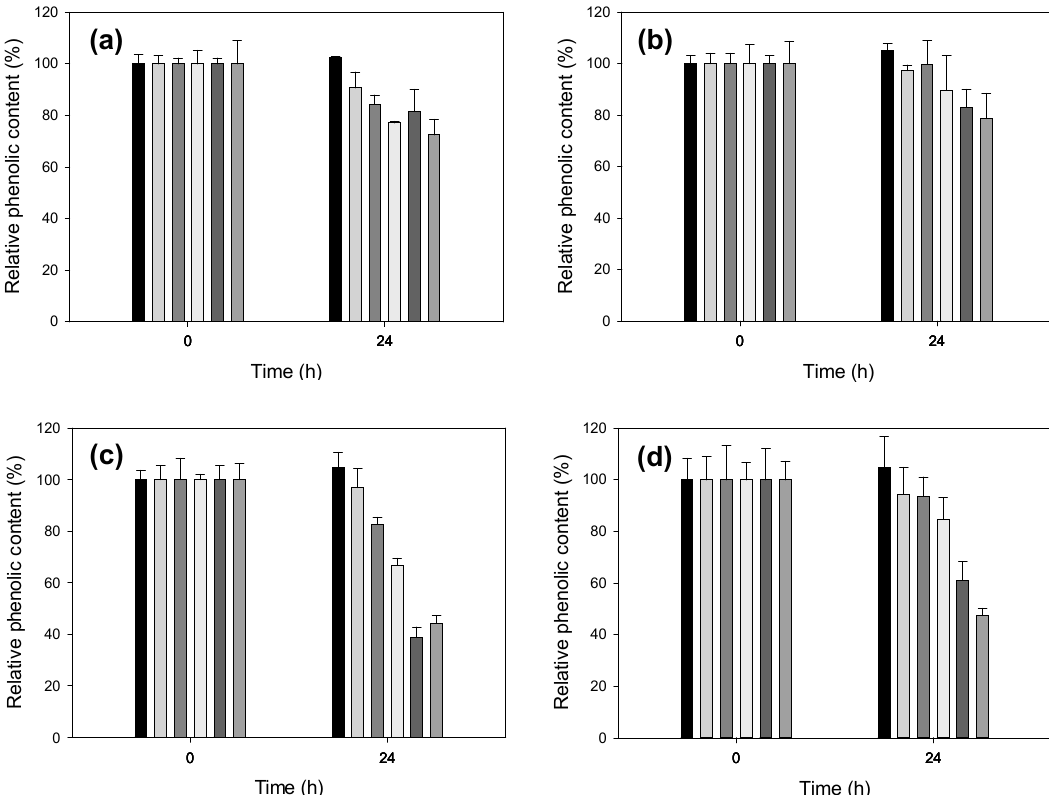
Figure 2. Variation in the relative phenolic content of lignosulfonates DP399 5 g/L ( a ) or 10 g/L ( b ), and DP401 5 g/L ( c ) or 10 g/L ( d ), after 24 h of reaction with different amounts of LAC7. From left to right: 0, 5, 10, 20, 50 and 100 mU/mL of laccase activity. Error bars indicate standard deviation for three replicates.